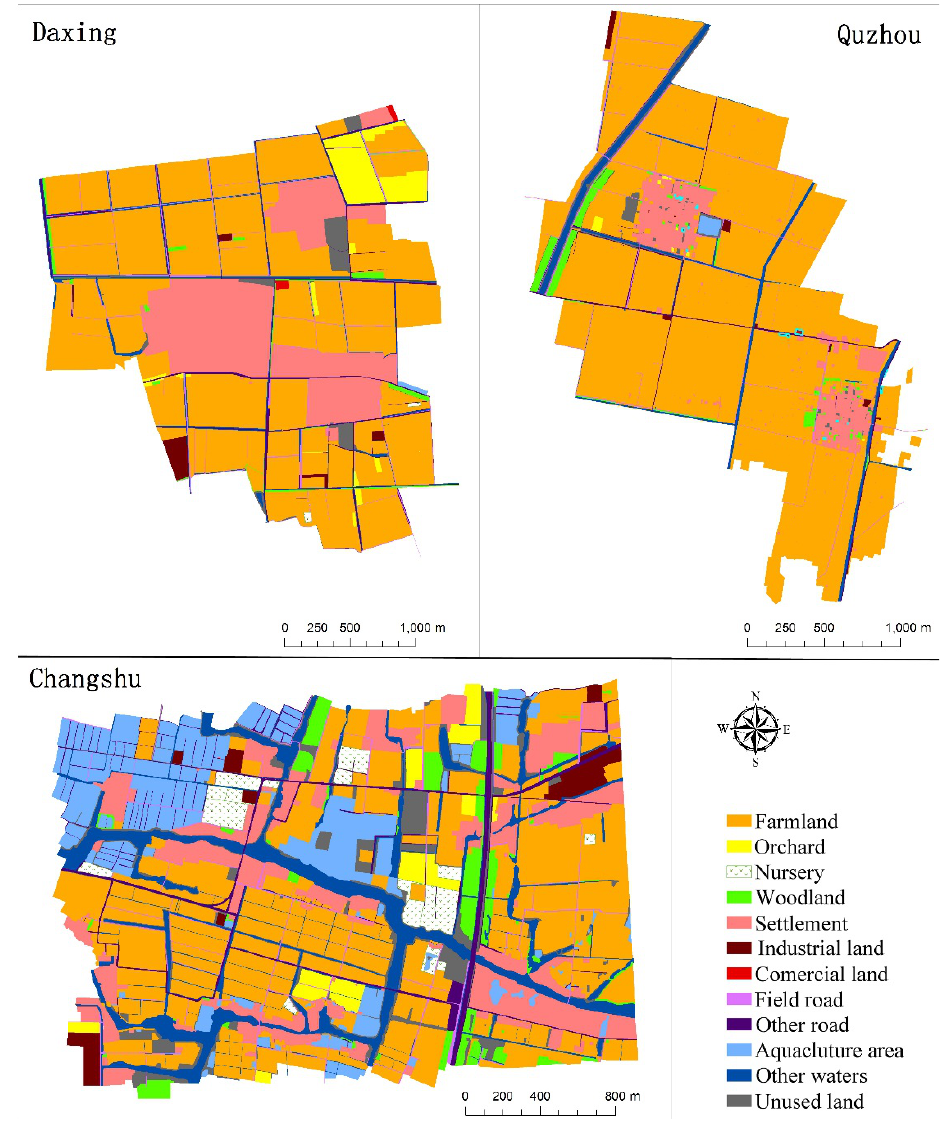
Figure 3. Land use map of the three study areas in 2012.